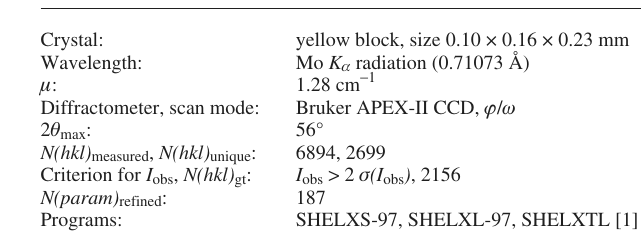
Table 1. Data collection and handling.